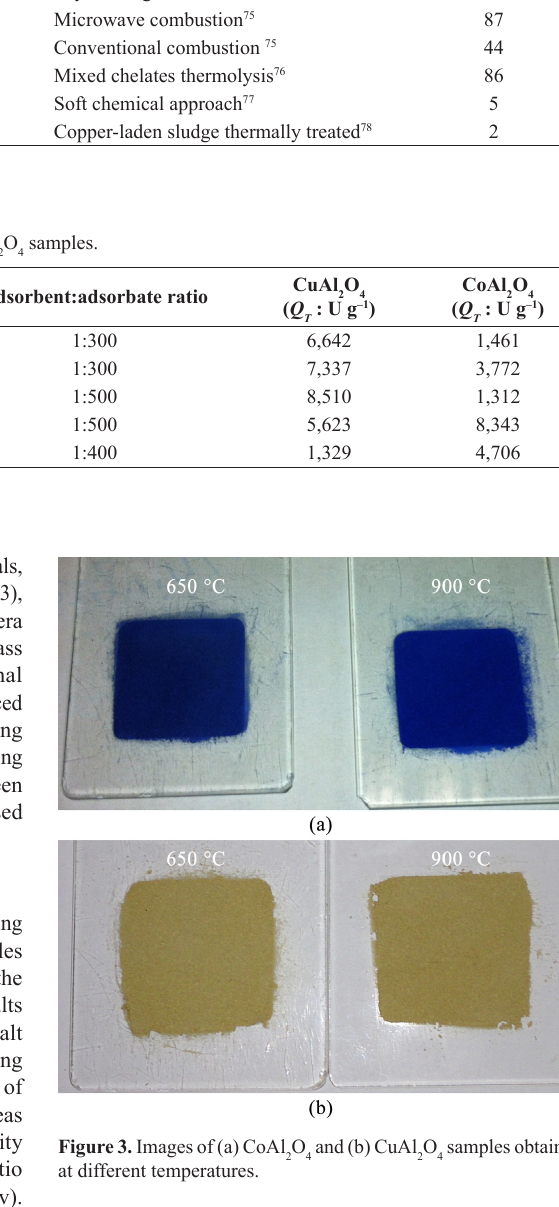
O and (b) CuAl 2 4